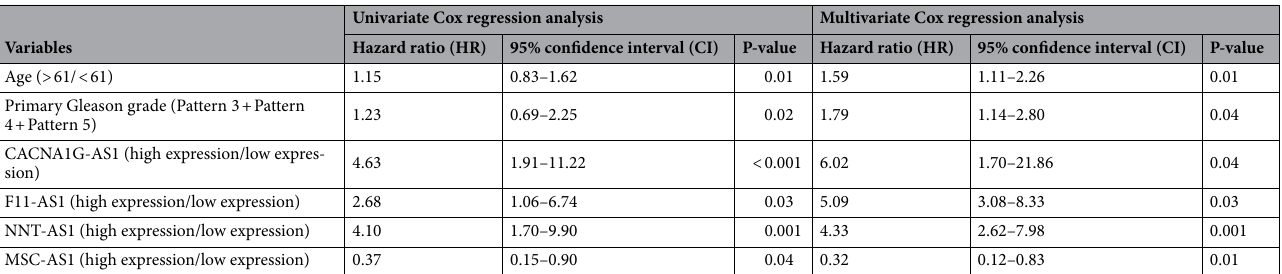
Table 1. Cox regression analysis (univariate and multivariate) of the variables associated with the overall survival of the prostate cancer